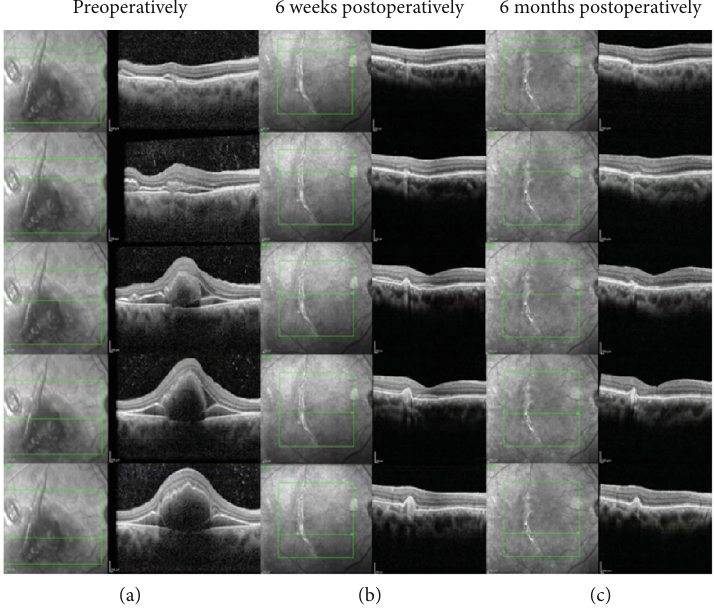
Figure 4: Preoperative spectral-domain optical coherence tomography (SD-OCT) of the corresponding macular locus images. Preoperative SD-OCT (left vertical column), 6-week postoperative SD-OCT (central vertical column), and 6-month postoperative comparative SD-OCT (right vertical column). (a – c) SD-OCT cross-sectional images acquired along the horizontal plane through the foveal center depict the involuted presence of blood and the sequential slow improvement of the retinal pigment epithelium, IS/OS, and external limiting membrane